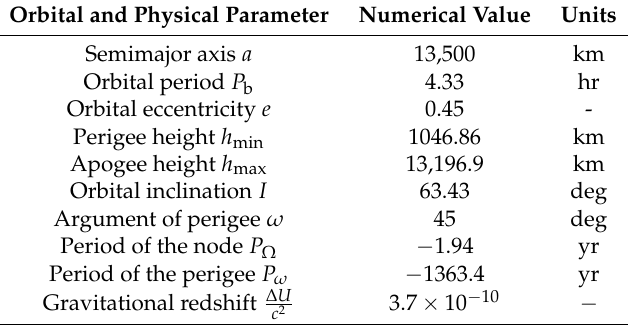
Table A3. Nominal pN (first four rows from the top) and mismodeled Newtonian (first seven rows from the bottom) rates of change, averaged over one orbital revolution, of the semimajor axis a , the eccentricity e , the inclination I , the longitude of the ascending node Ω , the argument of pericenter ω , and the mean anomaly at epoch η for the ideal (no orbital injection error on I assumed) orbital configuration of Table A2. The units are cm yr − 1 for (cid:104) ˙ a (cid:105) , and mas yr − 1 for (cid:104) ˙ e (cid:105) , The uncertainties in the classical rates of change due to the geopotential are the formal, statistical errors σ J in J (cid:96) , (cid:96) = 2, 3, . . . 8 of the model Tongji-Grace02s [48] quoted in TableA1. (cid:96)